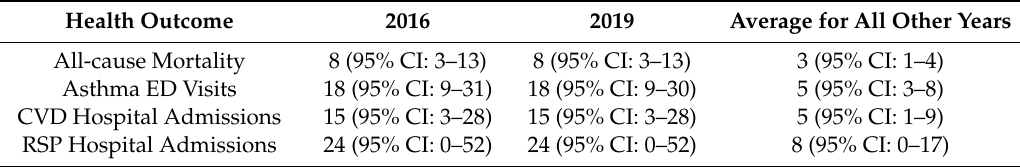
Table 4. Estimated number of cases attributable to LFS per health outcome for 2016, 2019, and average for all other years.